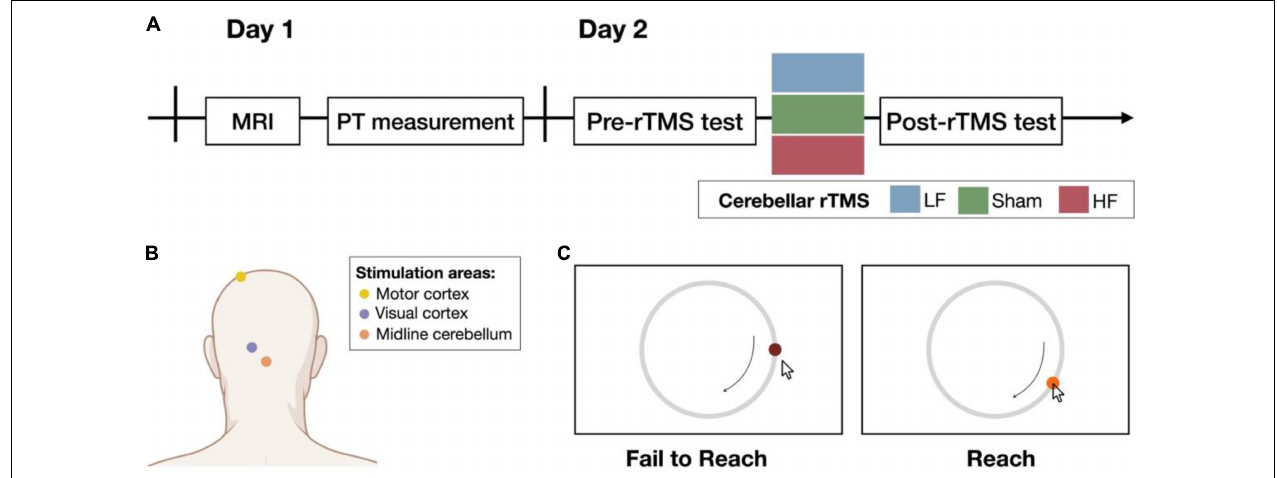
FIGURE 1 | Experimental procedure. (A) On day 1, structural imaging was performed before the experiment began. The phosphene threshold (PT) was measured and used as the reference output intensity for cerebellar rTMS. On day 2, participants were randomly assigned to one of the three groups: low-frequency (LF), sham, or high-frequency (HF) group. Performance on the behavioral task was assessed before and after the cerebellar rTMS intervention. The control experiments followed the same procedure on day 2 in the following 2 weeks. (B) The yellow and purple dots illustrate the target site of the resting motor threshold (rMT) and PT on the motor and visual cortex, respectively. The orange dot illustrates the midline cerebellum, the target of interest for the cerebellar rTMS intervention (created with BioRender.com). (C) Participants were asked to follow a target that moves on a circular track. The color of the target was presented as the feedback about task success (right) or failure (left). If the participant did not reach the target, the target would not change color. Once the participant reached the target, the target turned light red, and participants could learn whether they reached the target to immediately improve their behavioral